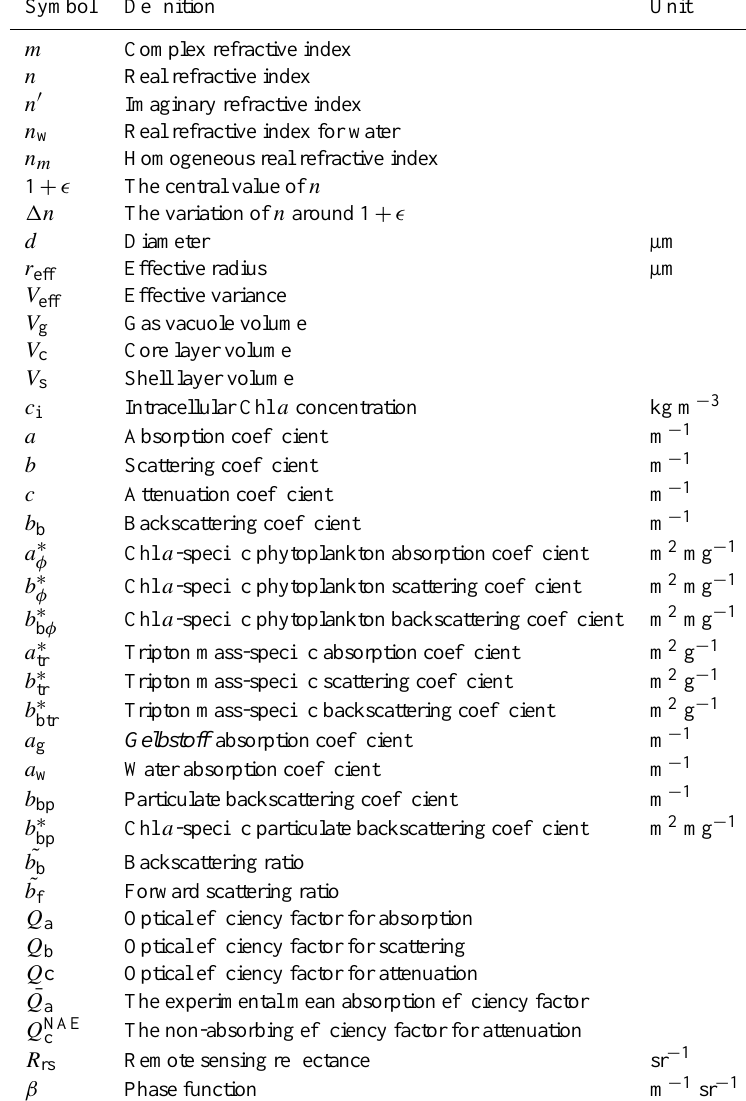
Table 1. Symbols and